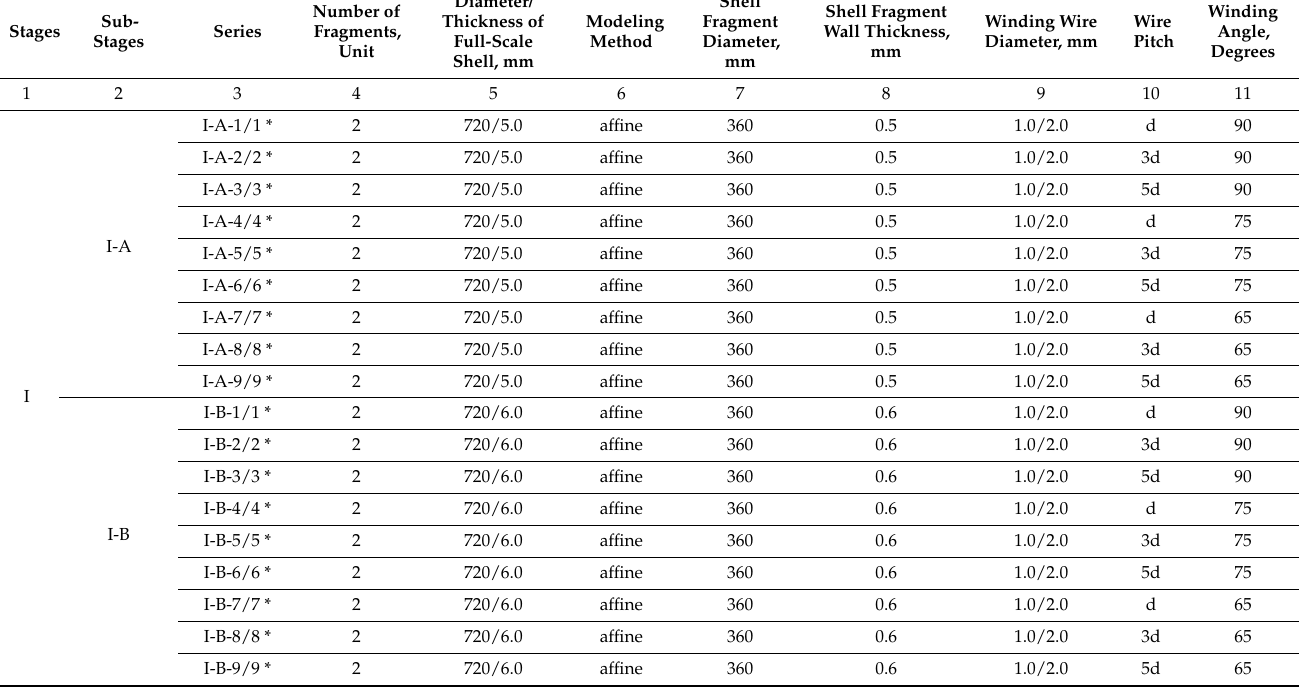
Table 1. Stages, sub-stages and series of